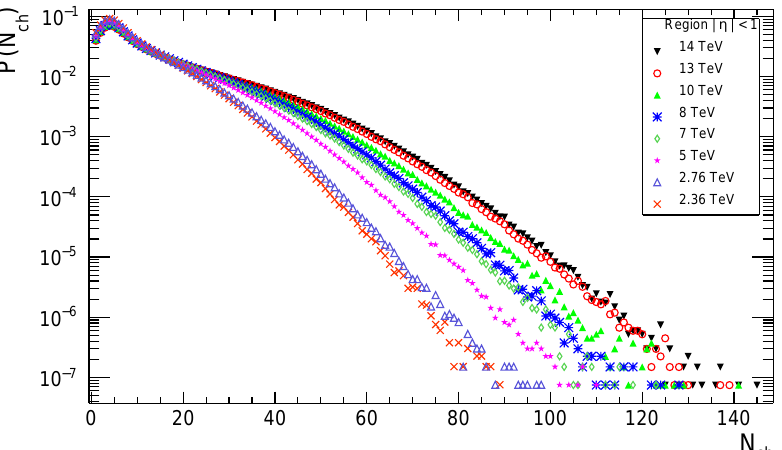
Figure 2. The charged particle multiplicity distribution in the pseudorapidity interval | η | < 1.0, with p T > 0.1